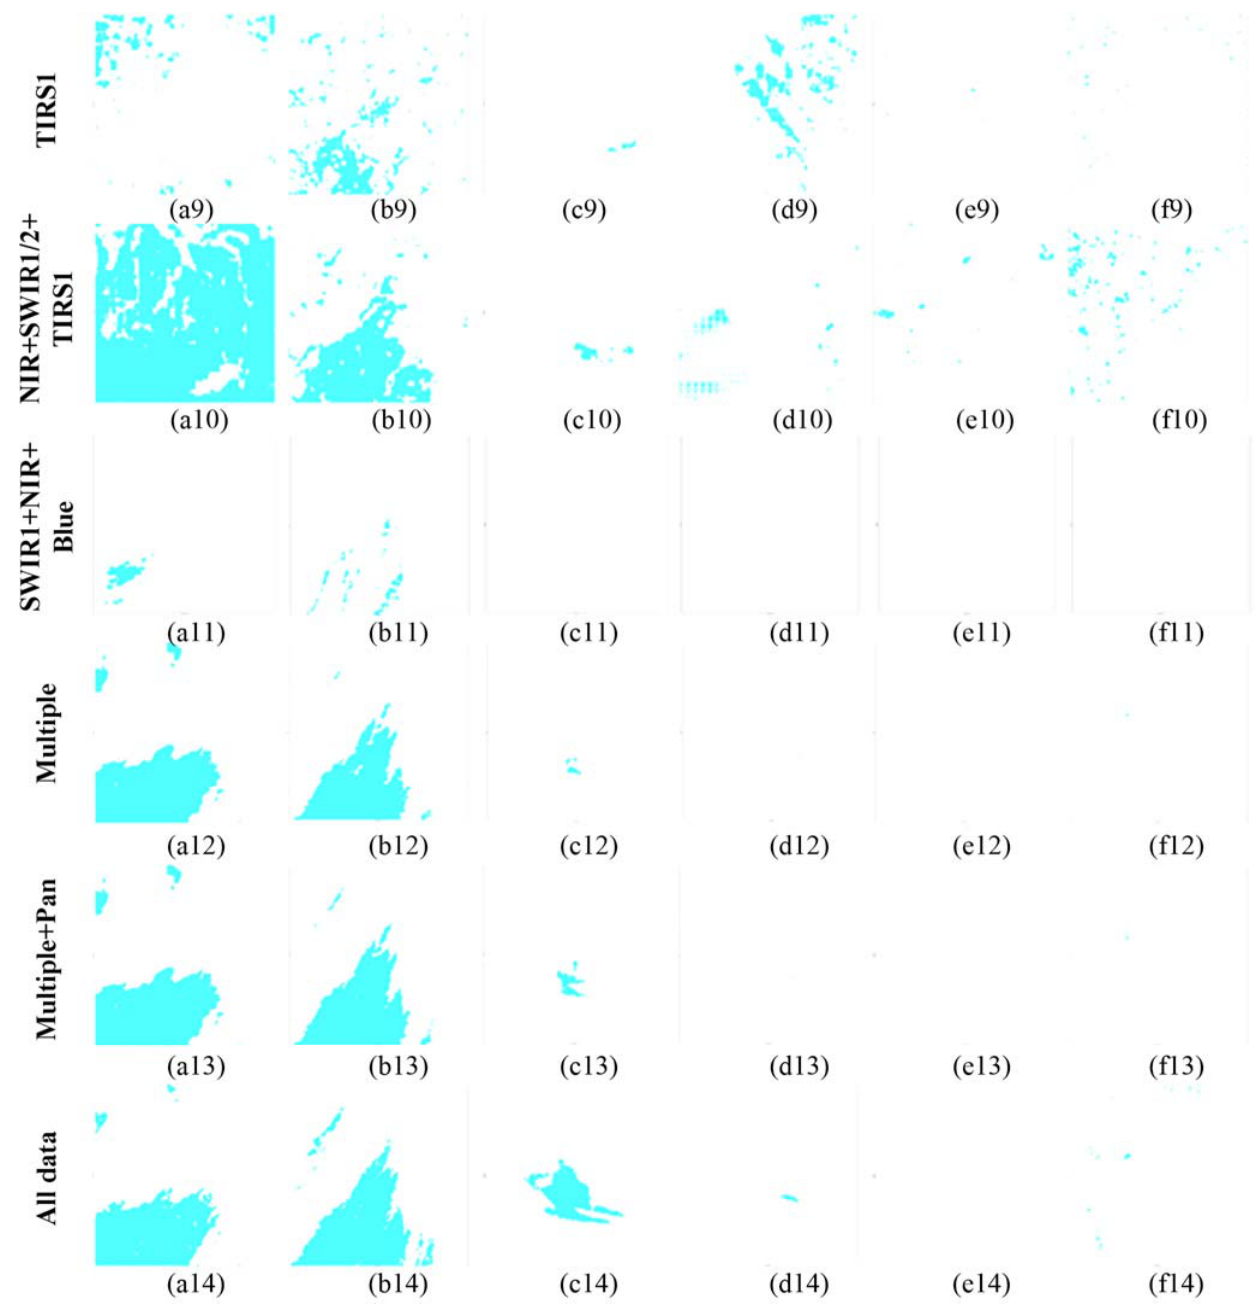
Figure 8. The first line shows true ‐ color composition RGB images of smoke plumes. ( a1–a14 ) Siberia area, Russia, on 17 March 2018; ( b1–b14 ) British Columbia, Canada, on 4 August 2017; ( c1–c14 ) Amazon region, Brazil, on 9 August 2019; ( d1–d14 ) New Zealand area, on 7 Feb 2019; ( e1–e14 ) Zambia, on 26 June 2017; ( f1–f14 ) Liangshan region, China, on 21 May 2019. All rows except the first are segmentation results of smoke with different input data, the smoke pixels are depicted in aqua color.